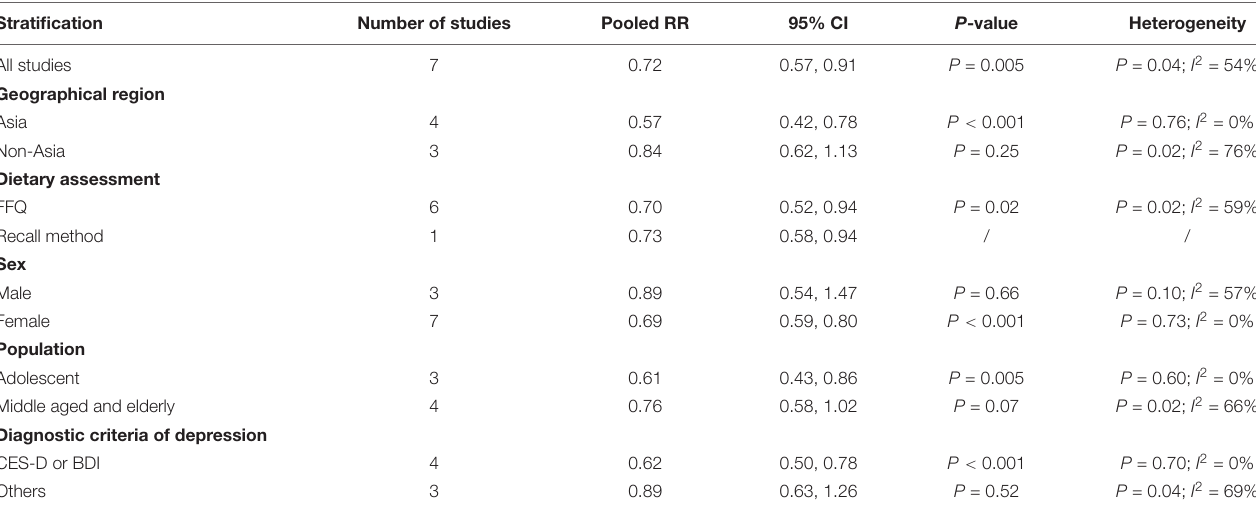
FIGURE 2 | Forest plot of meta-analysis: overall multi-variable adjusted RR of depression for the highest versus lowest category of dietary vitamin C intake. TABLE 2 | Subgroup analysis of depression for the highest versus lowest dietary vitamin C intake